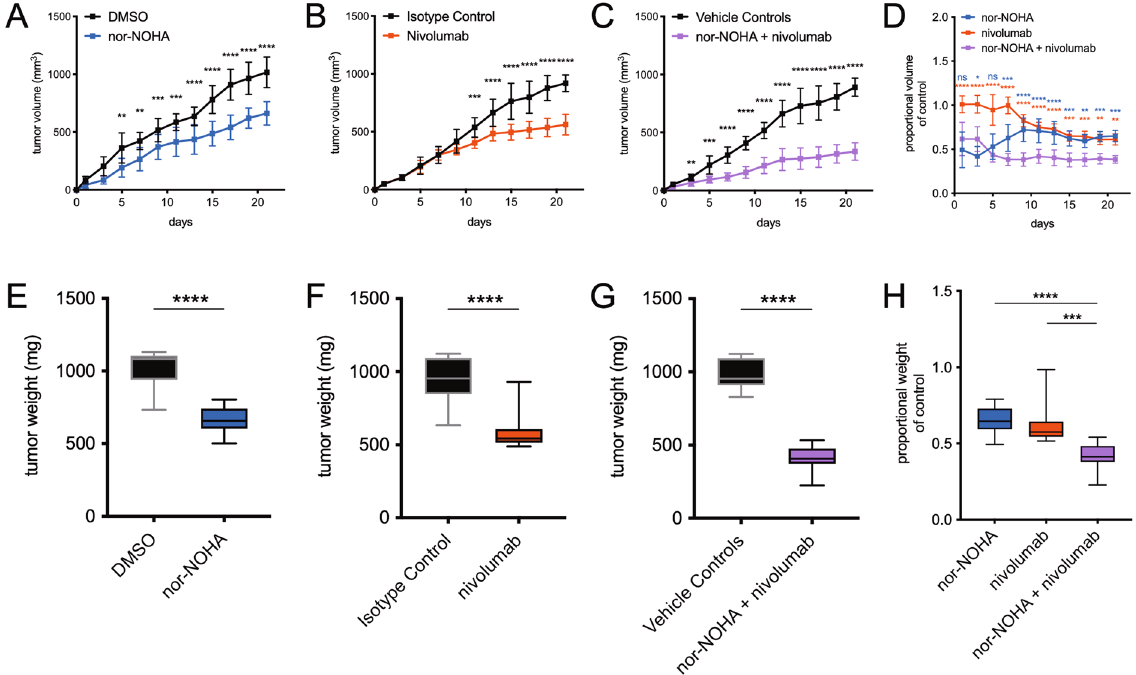
Figure 7. The combination of transcutaneous arginase inhibition and systemic PD-1 inhibition is synergistic in reducing PDVC57 tumor growth. ( A ) Growth curve of DMSO-treated compared to nor-NOHA-treated PDVC57 tumors, with a significant difference by day 5. ( B ) Growth curve of isotype control-treated compared to nivolumab-treated PDVC57 tumors, with a significant difference by day 11. ( C ) Growth curve of vehicle controls-treated compared to combination nor-NOHA + nivolumab-treated PDVC57 tumors, with a significant difference by day 3. ( D ) Proportional volume of nor-NOHA, nivolumab, and combination nor- NOHA + nivolumab compared to their respective vehicle controls; the combination treatment has significantly smaller proportional tumor volumes compared to either treatment alone. ( E ) Endpoint tumor weight of DMSO-treated compared to nor-NOHA-treated PDVC57 tumors; nor-NOHA-treated tumors were significantly lower in weight. ( F ) Endpoint tumor weight of isotype control-treated compared to nivolumab-treated PDVC57 tumors; nivolumab-treated tumors were significantly lower in weight. ( G ) Endpoint tumor weight of vehicle controls-treated compared to combination nor-NOHA + nivolumab-treated PDVC57 tumors; combination- treated tumors were significantly lower in weight. ( H ) Proportional endpoint tumor weight of nor-NOHA, nivolumab, and combination nor-NOHA + nivolumab treatments compared to their respective vehicle controls; the combination treatment has significantly smaller proportional tumor weights compared to either treatment alone. * P < 0.05; ** P < 0.01; *** P < 0.001; **** P < 0.0001 using the unpaired t -test adjusted for multiple comparisons. Two separate experiments with n > 5 per